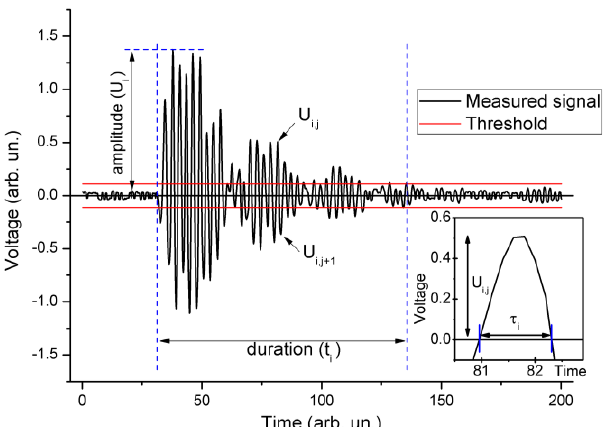
Figure 5. Typical measured signal belonging to one acoustic event with a medium energy. The insert shows one oscillation of the event. The index “ i ” refers to the number of the AE event, while index “ j ” refers to the number of oscillations in the i -th event,1 ≤ j ≤ n i , where n i is the total number of oscillations for the i -th event. τ i ≈ t i / n i (see also the text). Table 3. Critical energy exponents, , and energies of hits in the acoustic noises for heating and cooling at 10 K/min for the quenched, austenite stabilized and SIM-aged Ni 51 Fe 18 Ga 27 Co 4 single crystals. E t is the sum of peak energies ( ∑ 𝐸 𝑖 ) 𝑖 , E av is the average peak energy ( 𝐸 𝑎𝑣 = the number of hits). The energies are given in ∙V 2 ∙ −1 s units.